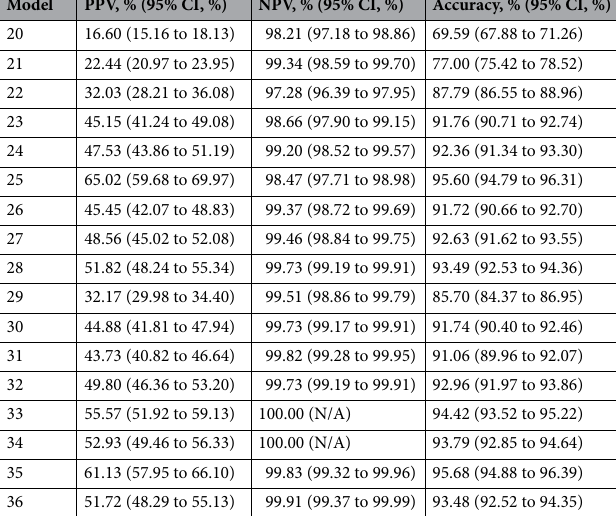
Table 3. Effects of prevalence on screening performance of each model: Italy (prevalence, 6.98%). CI confidence interval, PPV positive predictive value, NPV negative predictive value, N/A not